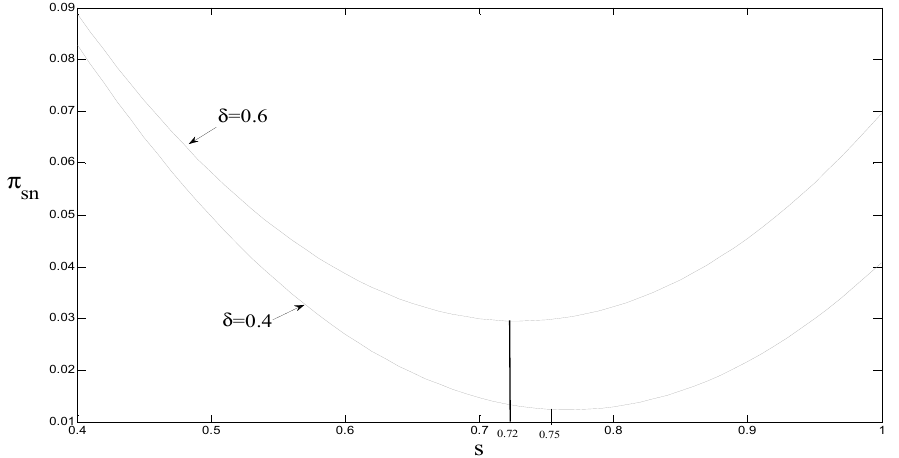
Figure 7. The impact of s on the revenue of original manufacturers.